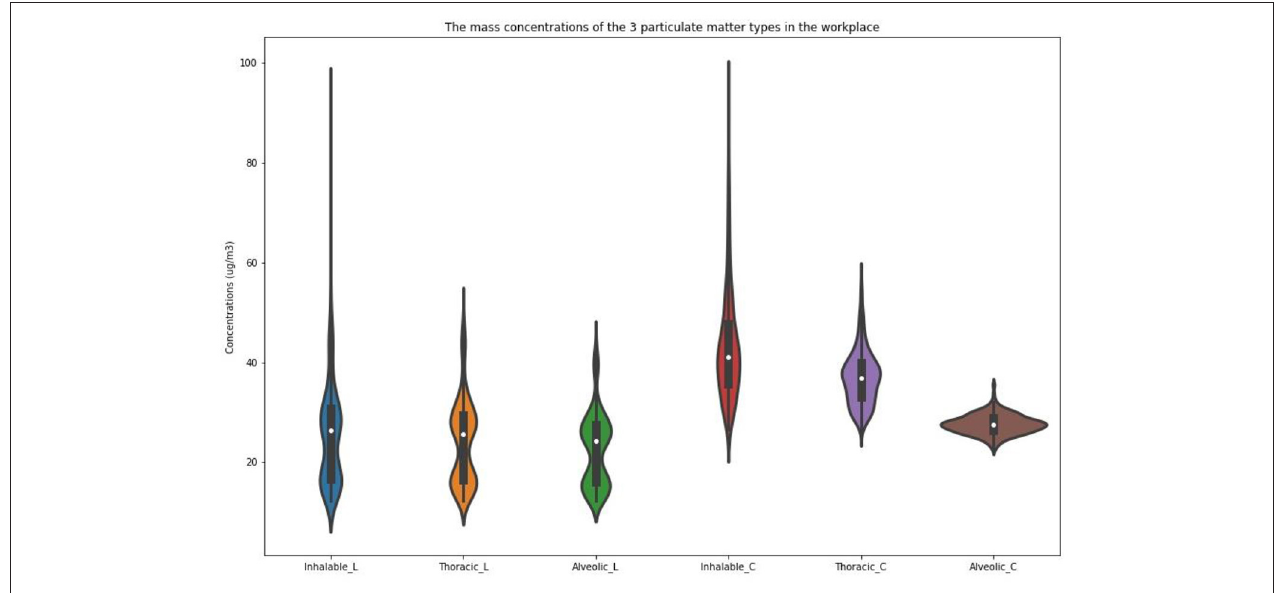
FIGURE 9 | Assessment of the mass concentrations of the 3 particulate matter types in the workplace based on the BS EN 481-1993 standard.